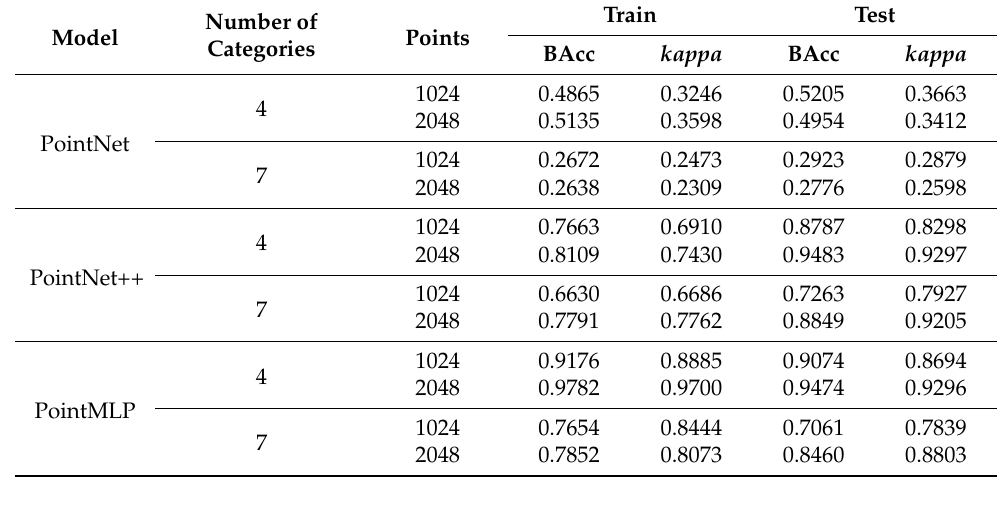
Table 3. Accuracy of tree species classification results for three deep learning models.